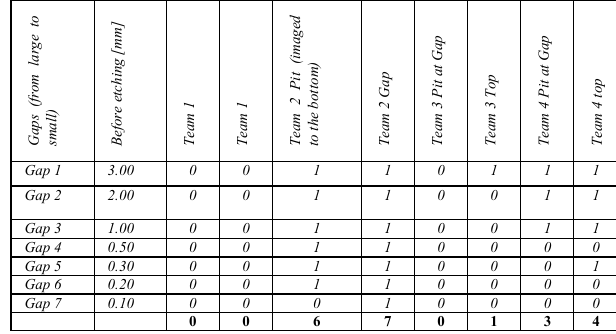
Table 4. Detected gaps in the structure. The number 1 indicates